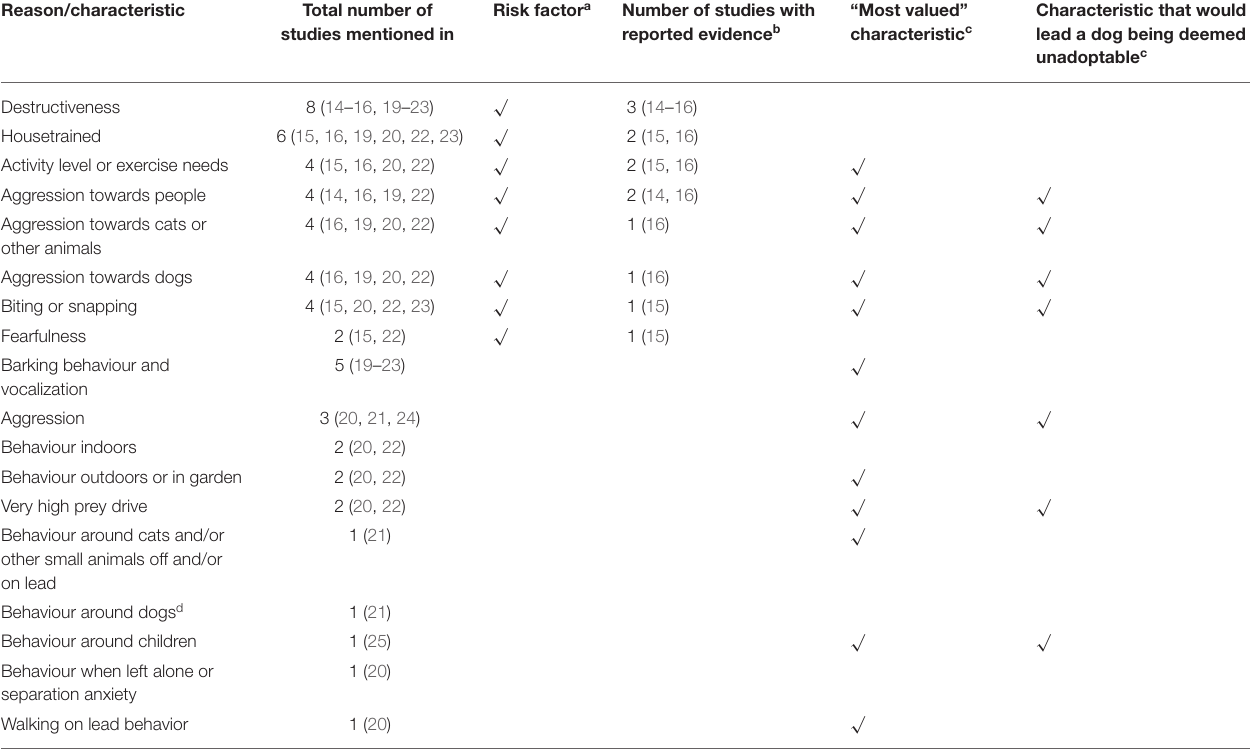
TABLE 4 | Dog assessment themes and sub-themes that are reported in the literature as reasons for relinquishment or characteristics of dogs as reported by surrendering owners.